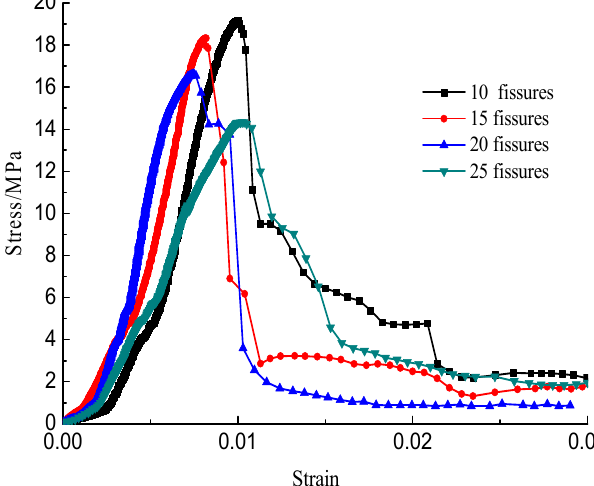
Figure 12. Stress–strain curves with a crack angle of 75°.